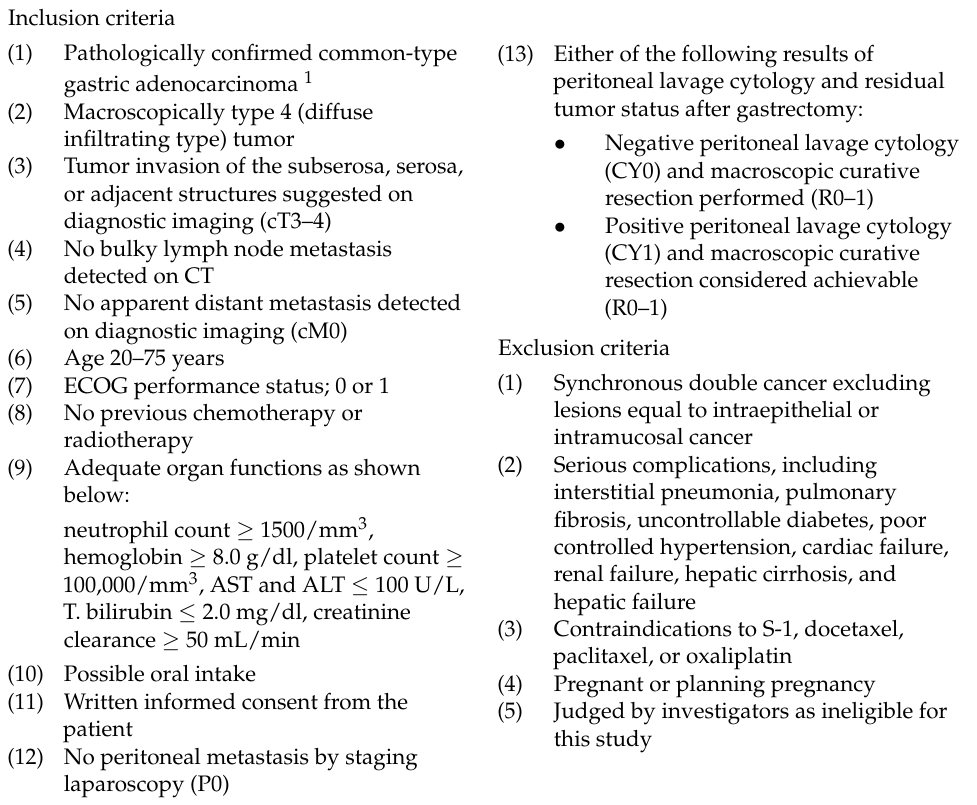
Table 1. Inclusion and exclusion criteria of the PHOENIX-GC2